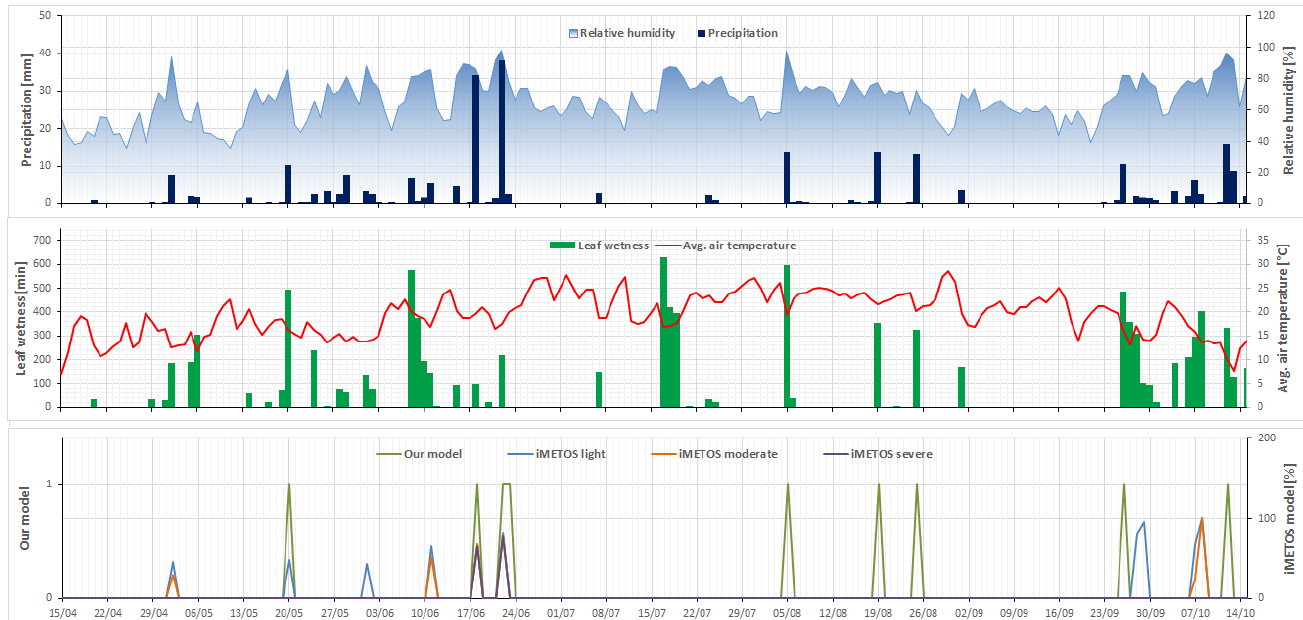
Figure 13. Primary infection alarms for the location ’Rimski Šanˇcevi’.